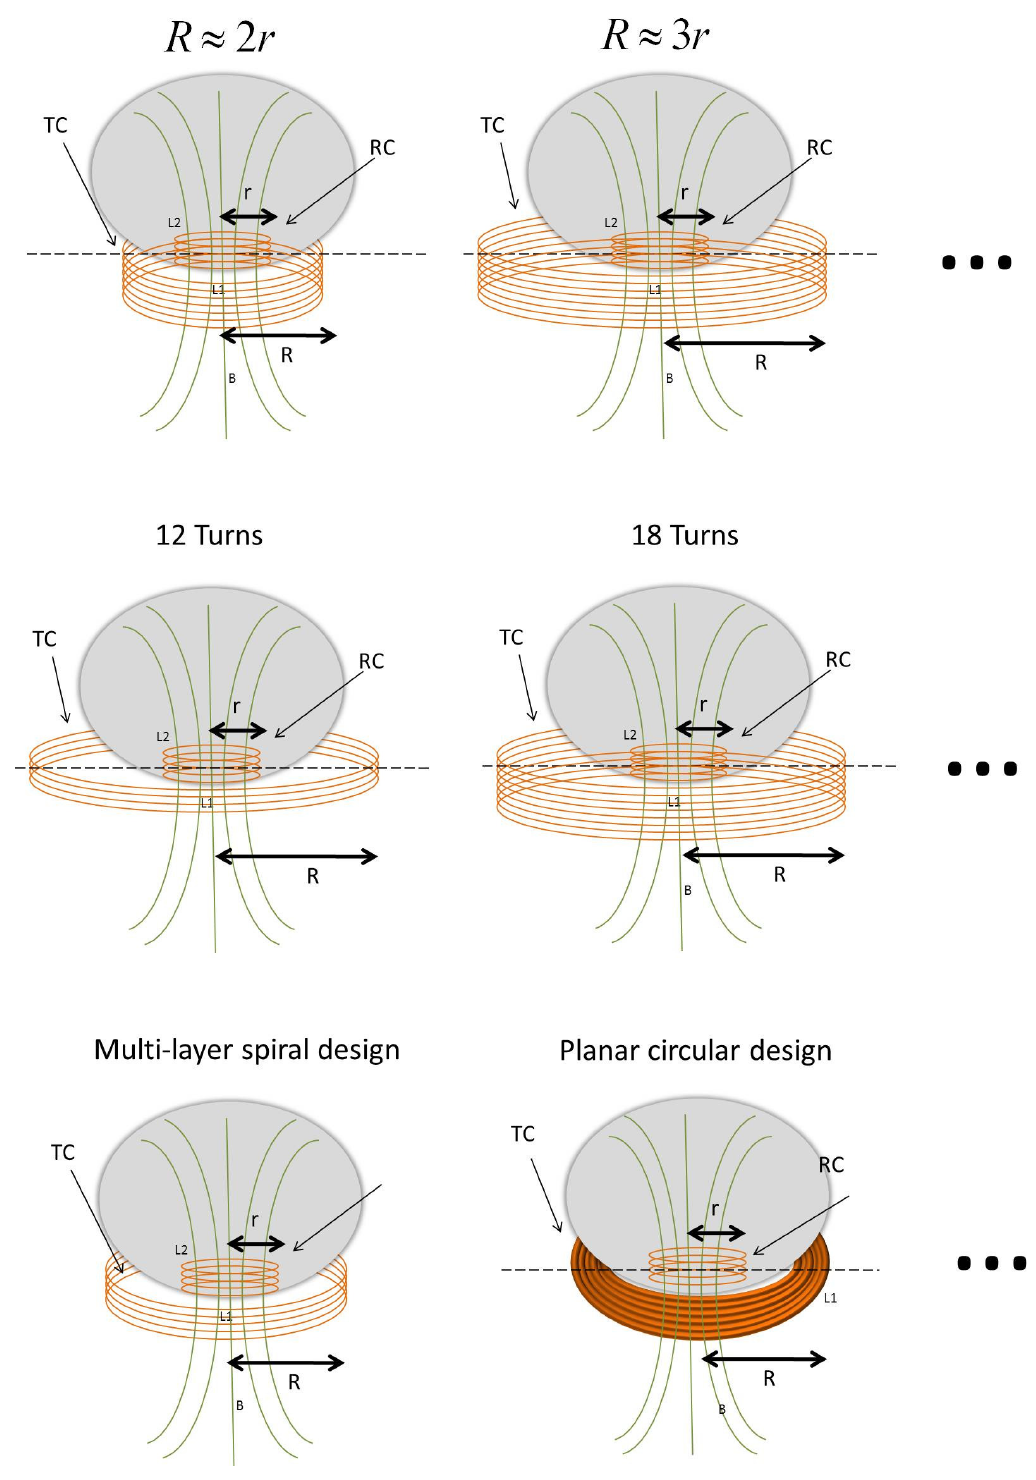
Figure 5. Examples of explored transmitter coils. RC (receiver coil) and TC (transmitter coil) are